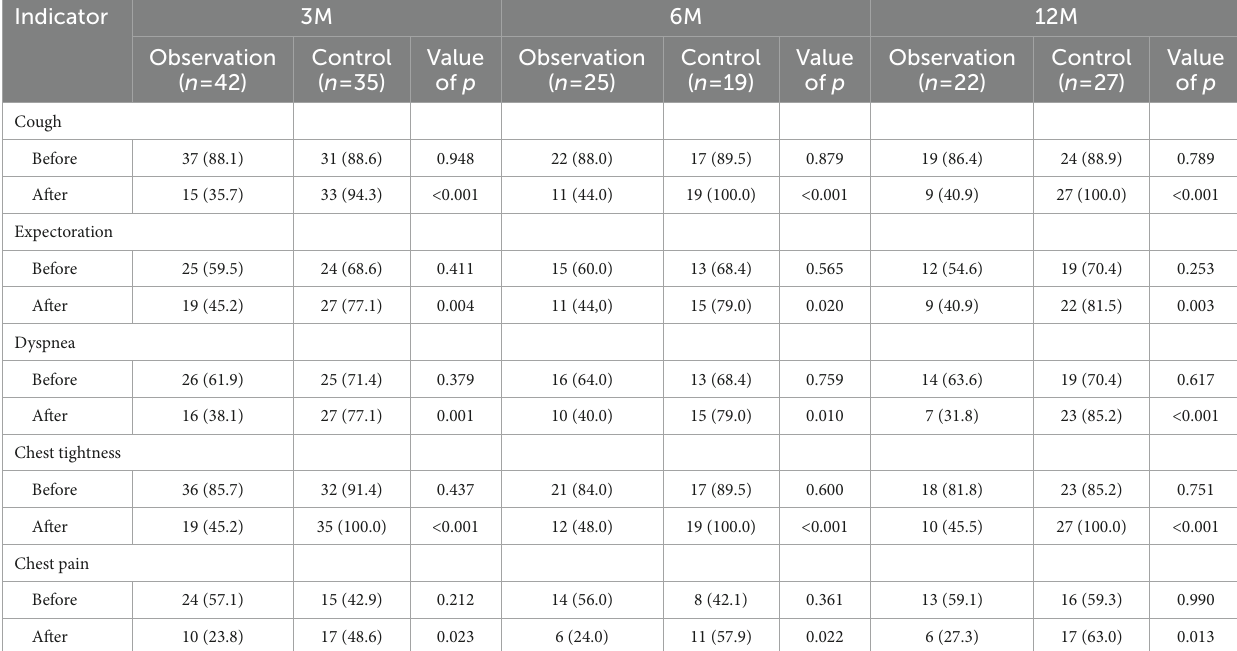
TABLE 4 Change of clinical symptoms [ n